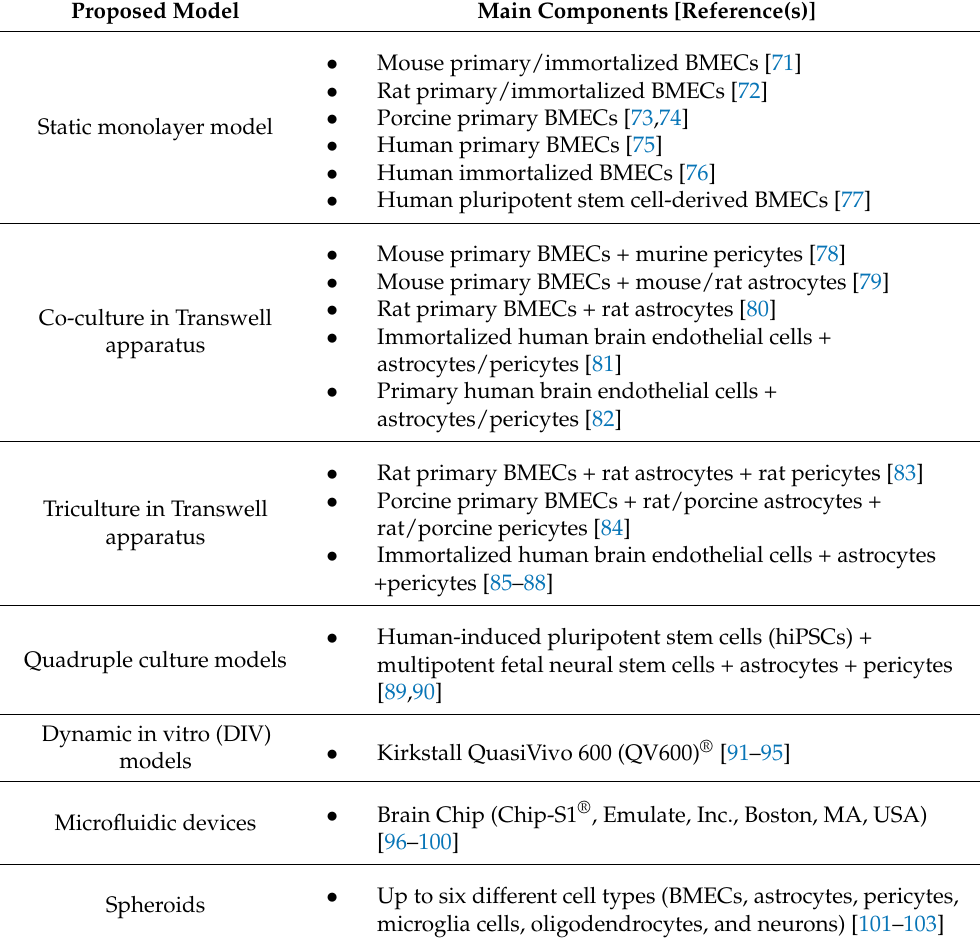
Table 1. BBB in vitro models—main components and most relevant